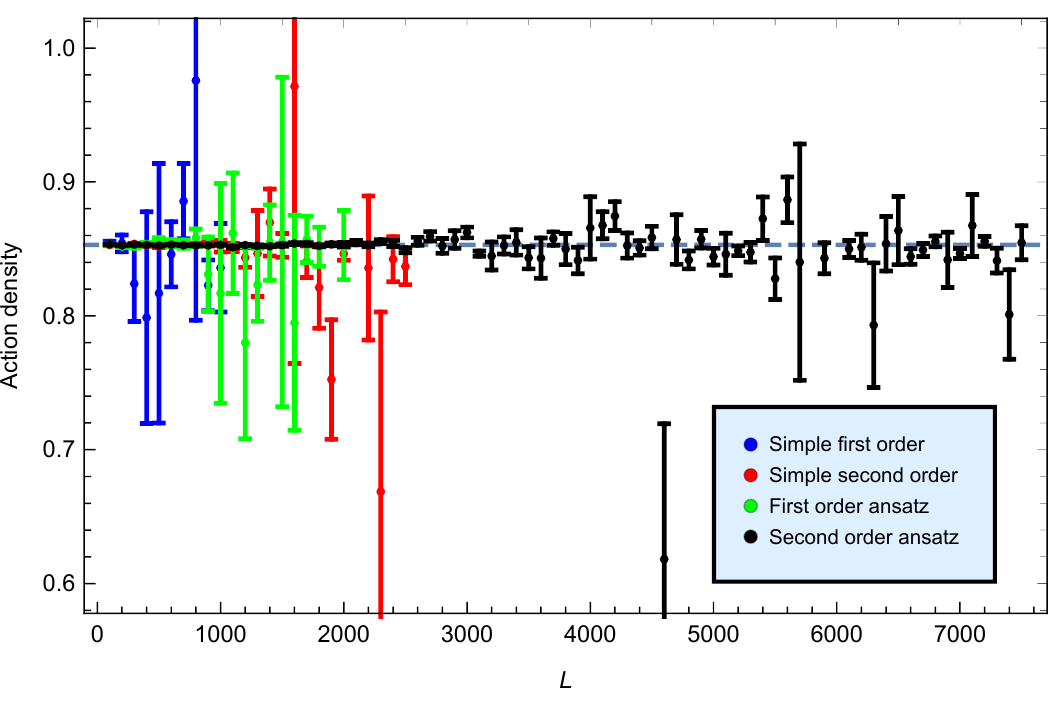
, as a function of lattice size for the various contours for m = 1 , Figure 17 . The action density, h S i L µ = 1 . For each contour we present the results up to somewhere beyond the point where the sign problem begins to become significant. A constant dashed line with the average value of the observable is presented for convenience. For the first order simple contour and the first order ansatz the results are consistent with those of paper I, which implies that the treatment of the special point is of no significant